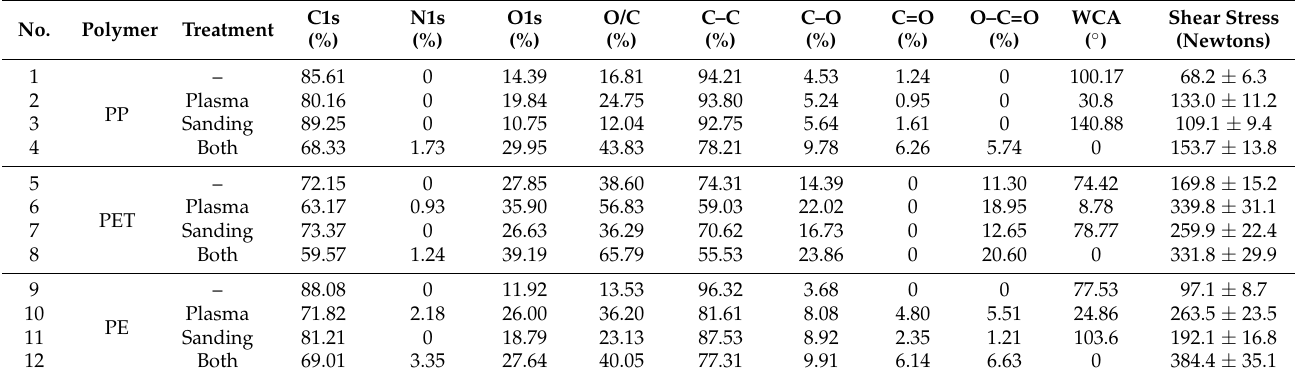
Table 1. Atomic percent concentration and ratio, percent peak area of XPS C1s core level spectra, the corresponded WCA and shear stress